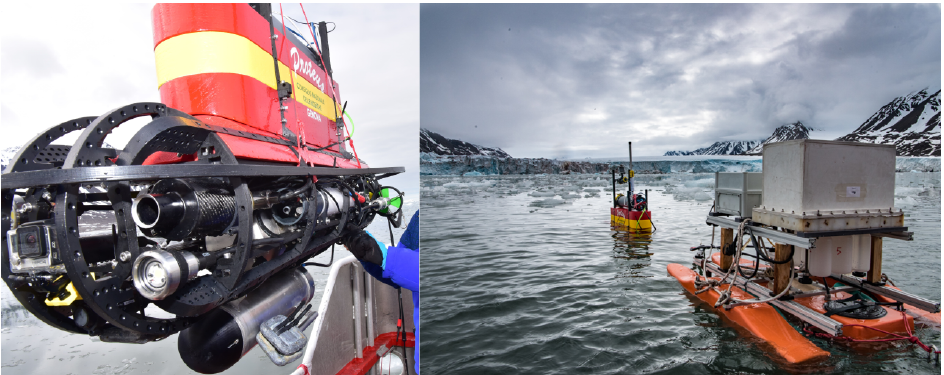
Figure 15. The 2017 campaign: PROTEUS ( left ) and PROTEUS towing the Trimaran vessel ( right ).